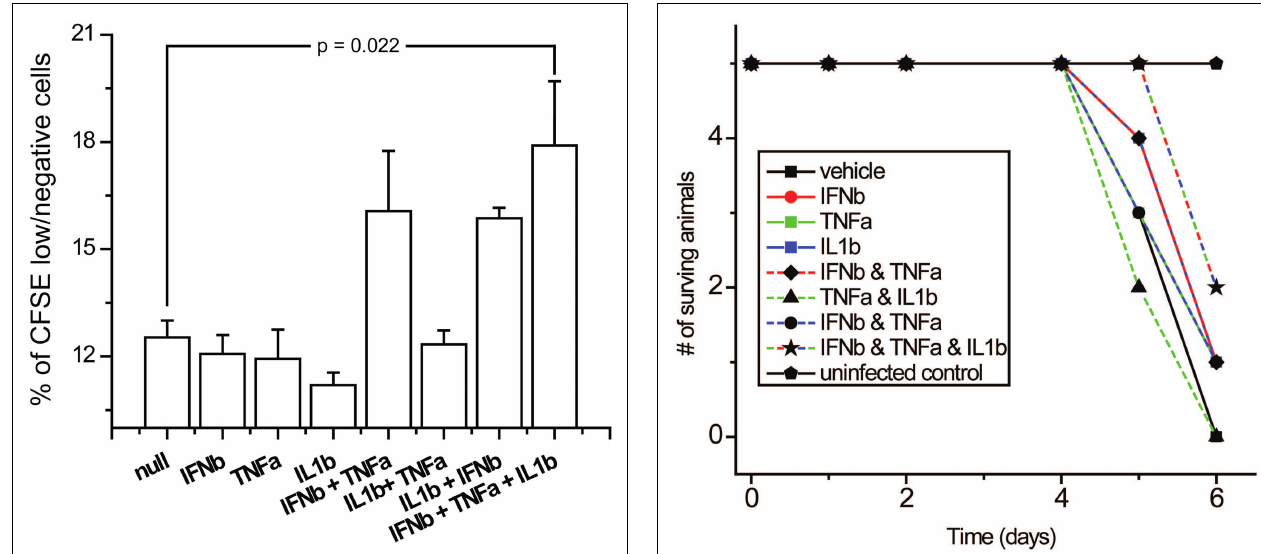
COMBINATORIAL EFFECT OF TNF α , IL1 β , AND IFN β ON INFLUENZA MORBIDITY IN VIVO